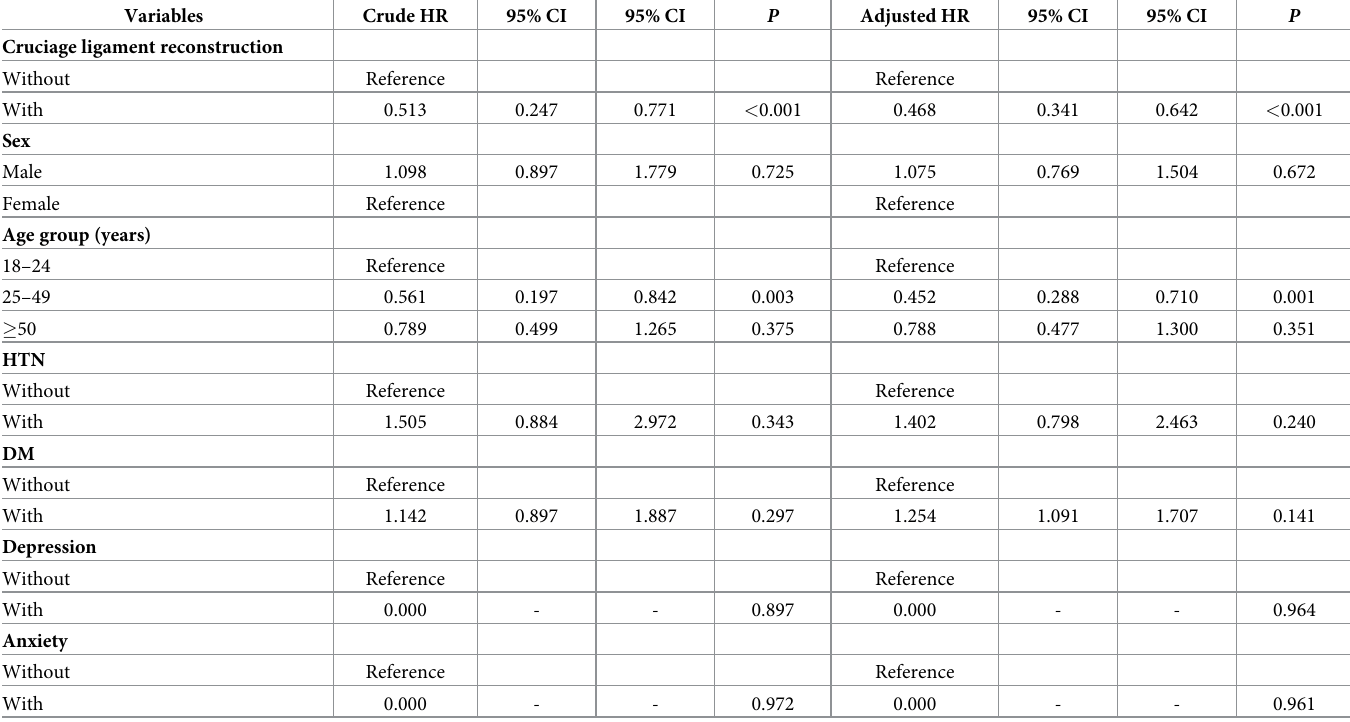
Table 3. HRs for poor prognoses in PCL-injured patients with and without reconstruction by using Cox regression.